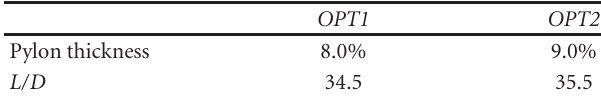
Table 3: Pylon thickness and L/D for two optimal solutions ( OPT1 and OPT2